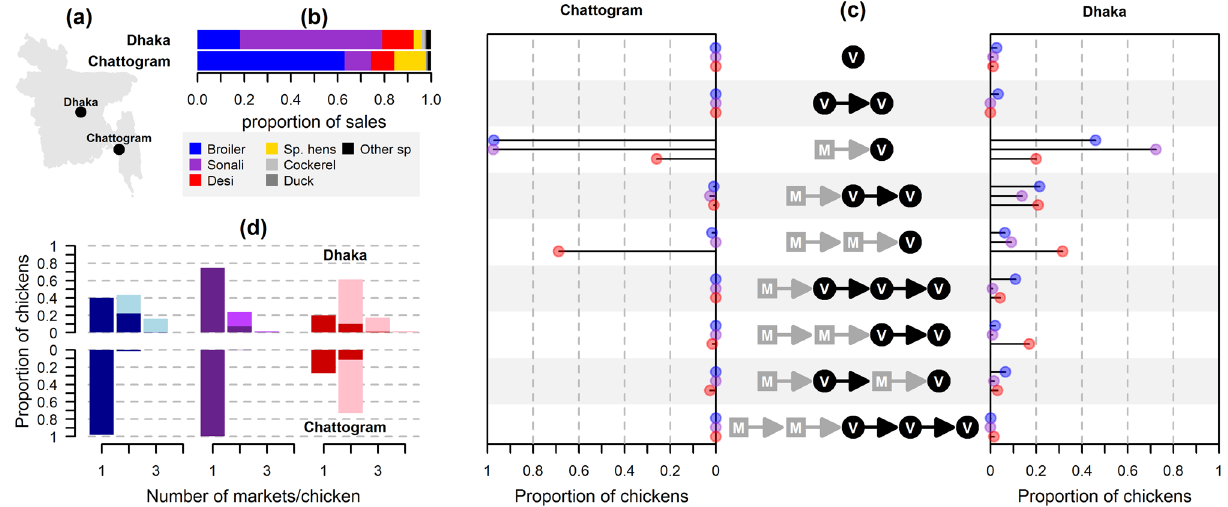
Figure 1. Type of poultry and chains of actors. ( a ) Map of Bangladesh; ( b ) proportion of sales of each poultry type in each city; Sp. hens: spent hens, Other sp: other species; ( c ) proportion of chickens traded through each possible combination of actors, supplying both cities in broilers (blue), sonalis (purple) and deshis (red); M mobile trader, V market vendor; ( d ) proportion of broilers (blue), sonalis (purple) and deshis (red) sold in Dhaka and Chattogram according to the number of markets through which they transited; darker: only involving markets in the supplied city, lighter: involving at least one market located outside the supplied city. Catchment areas were mapped using maptools 57 , road distances were computed using gmapsdistance 58